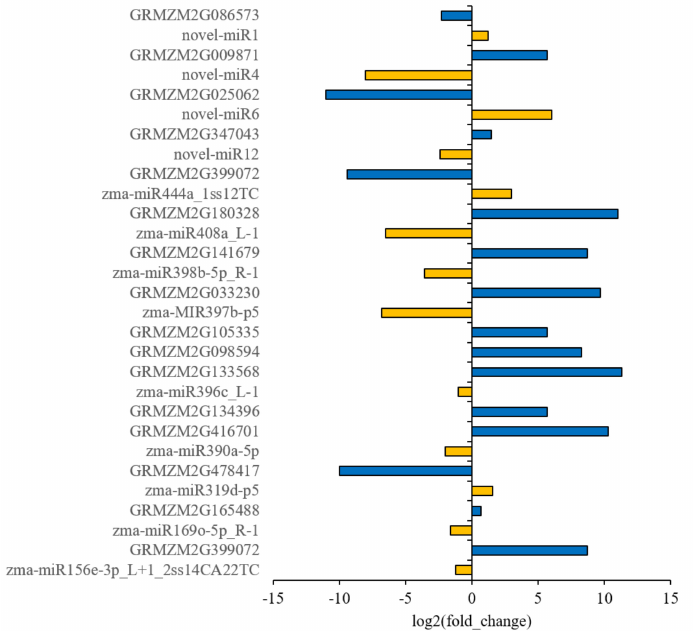
Figure 4. Differential expression of the known and putative miRNAs and target genes in maize. FC, fold change. Orange bars represent expression of miRNAs; blue bars represent expression of target genes.